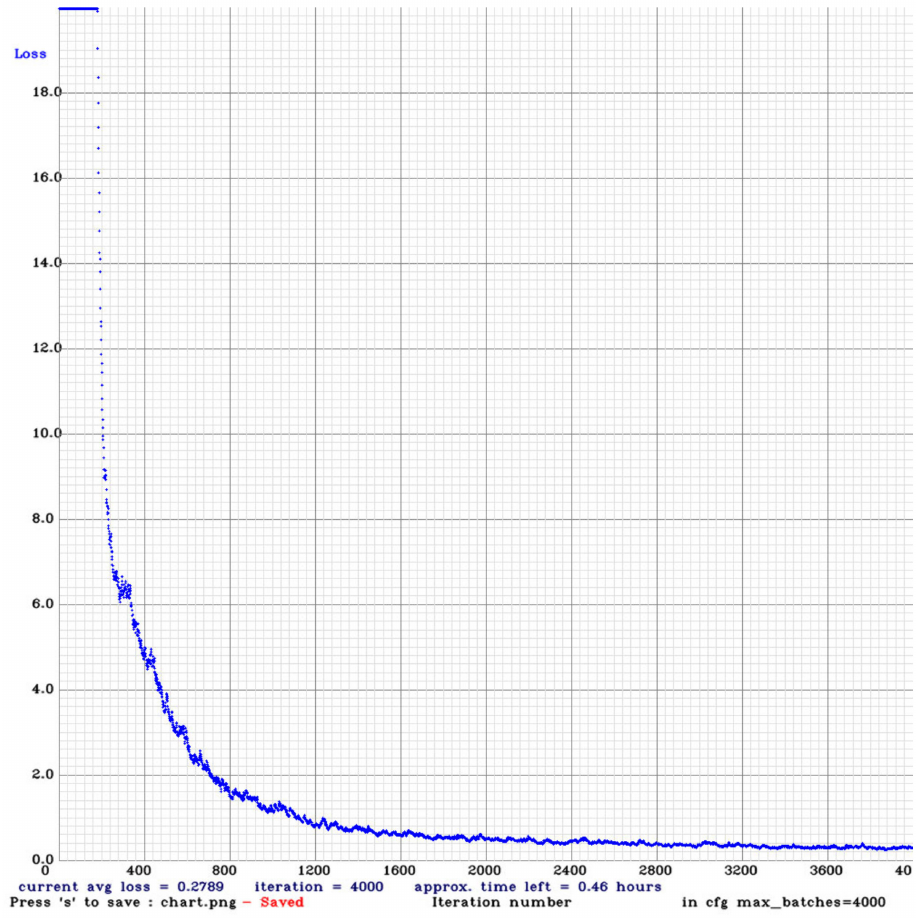
Figure 5. YOLOv4 Loss